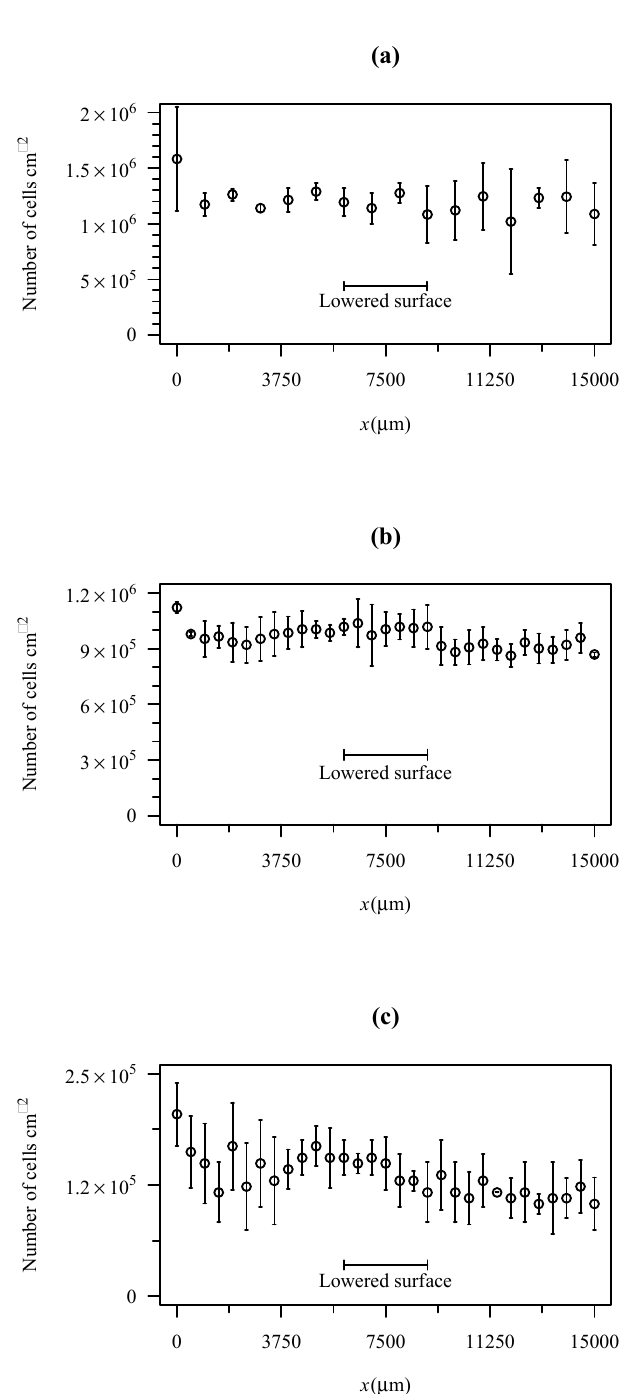
Figure 8. Cell density after 1800 s of adhesion on PDMS for three different nominal wall shear stresses. ( a ) WSS = 0.02 Pa; ( b ) WSS = 0.2 Pa; ( c ) WSS = 1 Pa.